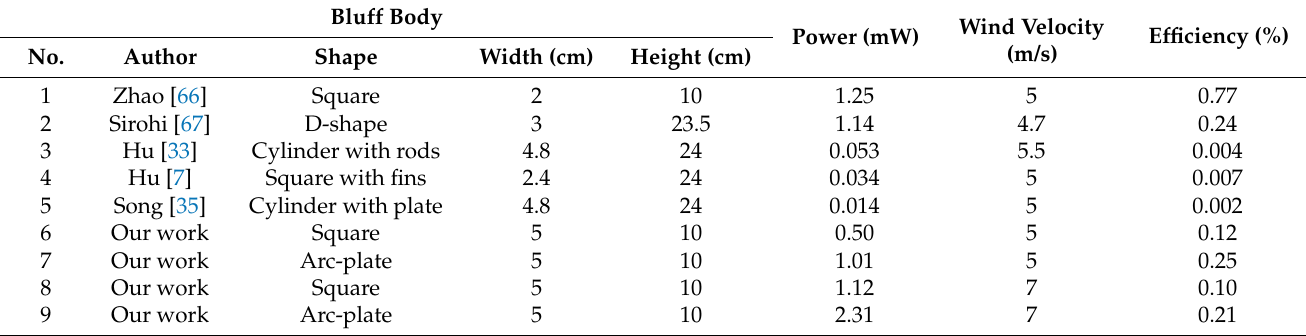
Table 3. Comparison of various galloping-based wind energy harvesters. Bluff Body